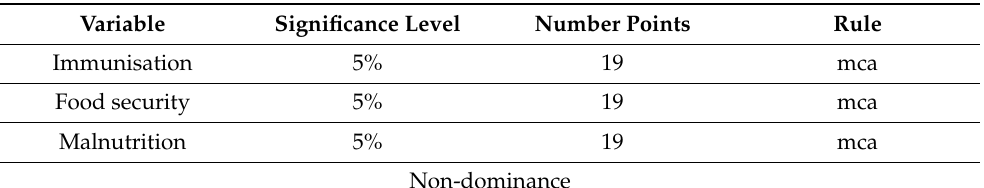
Figure 1. Concentration curves of Immunisation, Food security and Nutrition for ( a ) India & ( b ) South Africa.